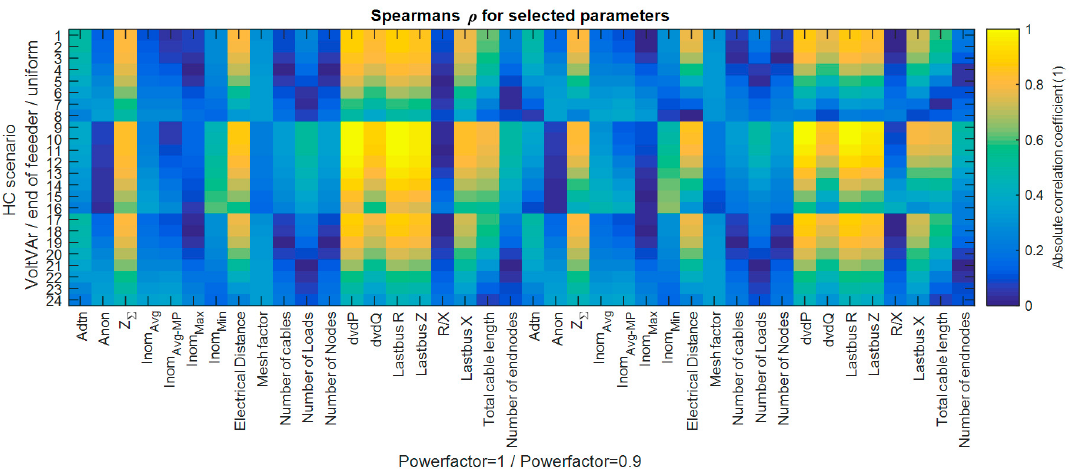
Figure 20. Spearman correlation (HC @ PF = 1 columns 1–8, HC @ PF = 0.9 columns 9–16, HC @ VoltVar columns 17–24).